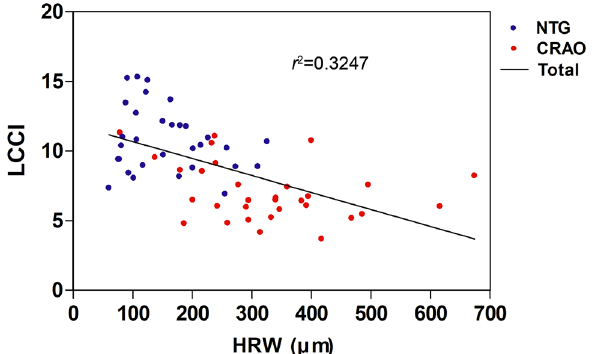
Figure 3. Scatter plot showing the relationship between the horizontal rim width (HRW) and the lamina cribrosa curvature index (LCCI) in normal tension glaucoma (NTG) and central retinal artery occlusion (CRAO) eyes. Overall, a larger HRW was associated with a smaller LCCI ( P < 0.001, r 2 = 0.3247) (solid line).